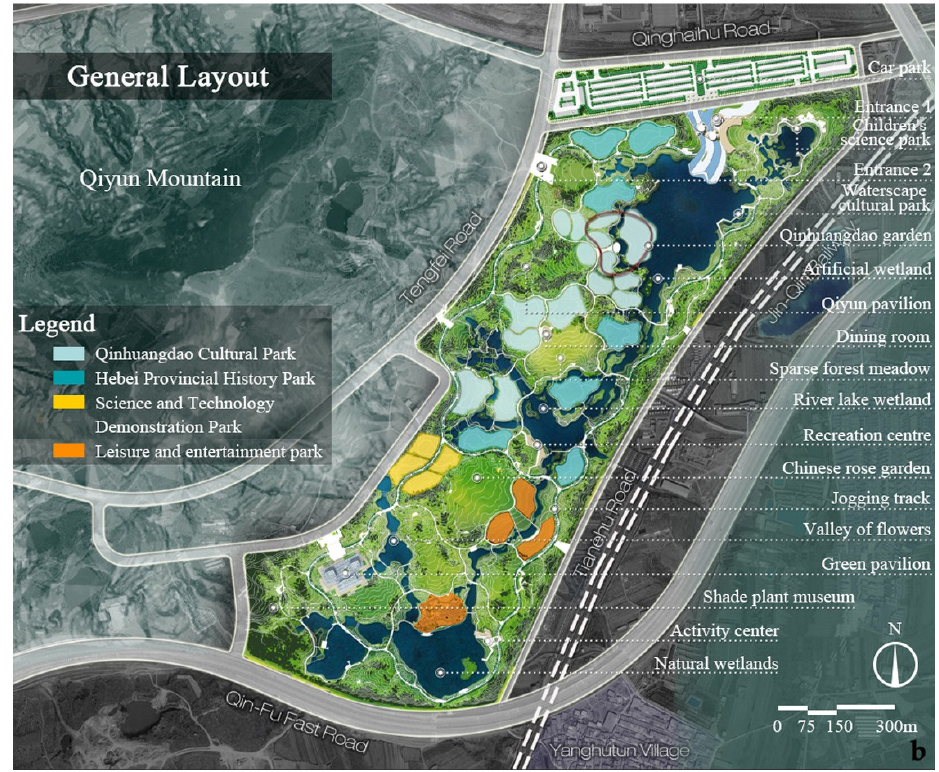
Figure 1. ( a ) Geographical location of the study area. ( b ) Study Area